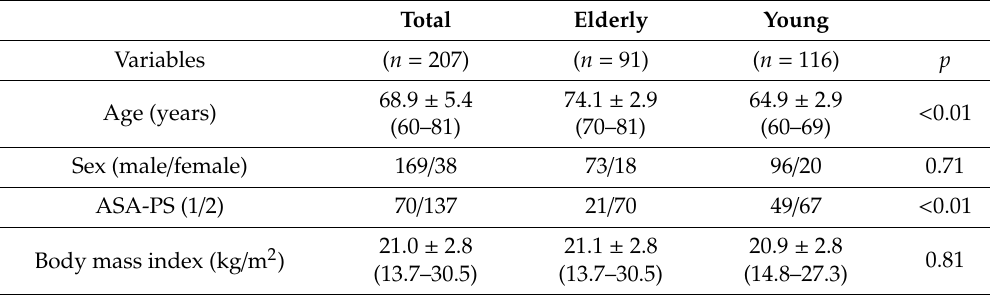
Table 1. Baseline characteristics of the elderly and young